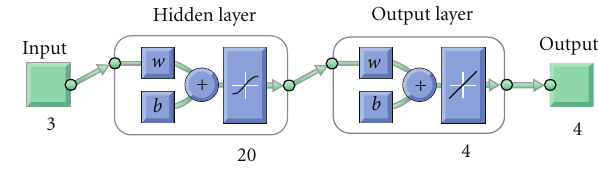
Figure 7: Architecture of the neural